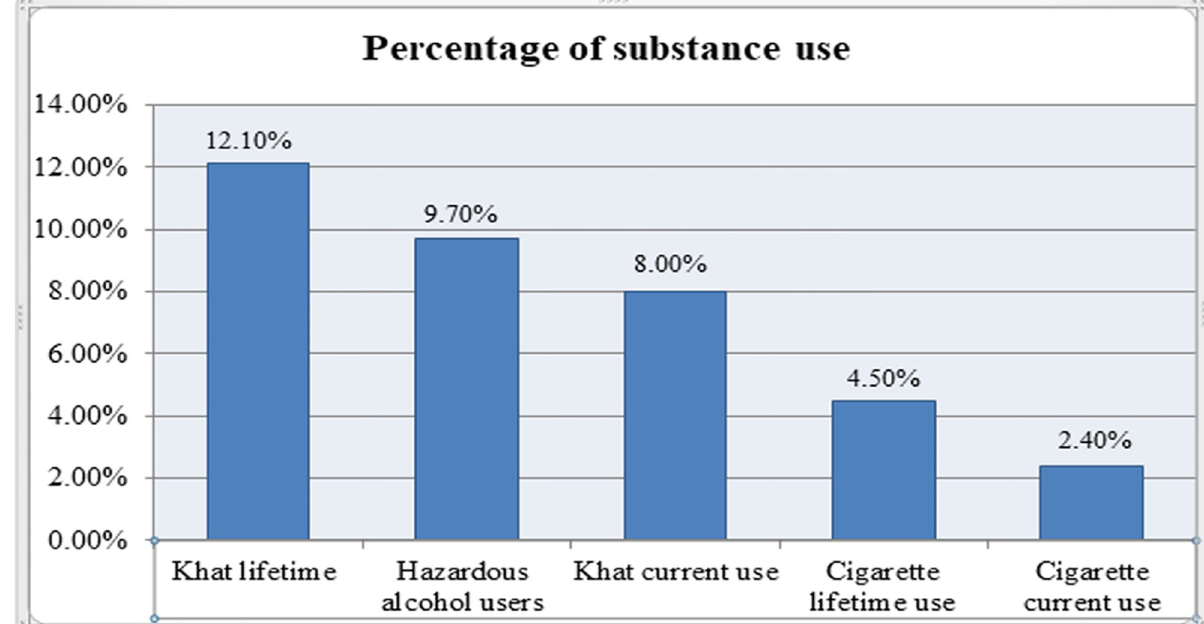
Fig 1. Ever and current substance use among older adults people in Bahir Dar city administration, northwest, Ethiopia, 2020 (n = 423).